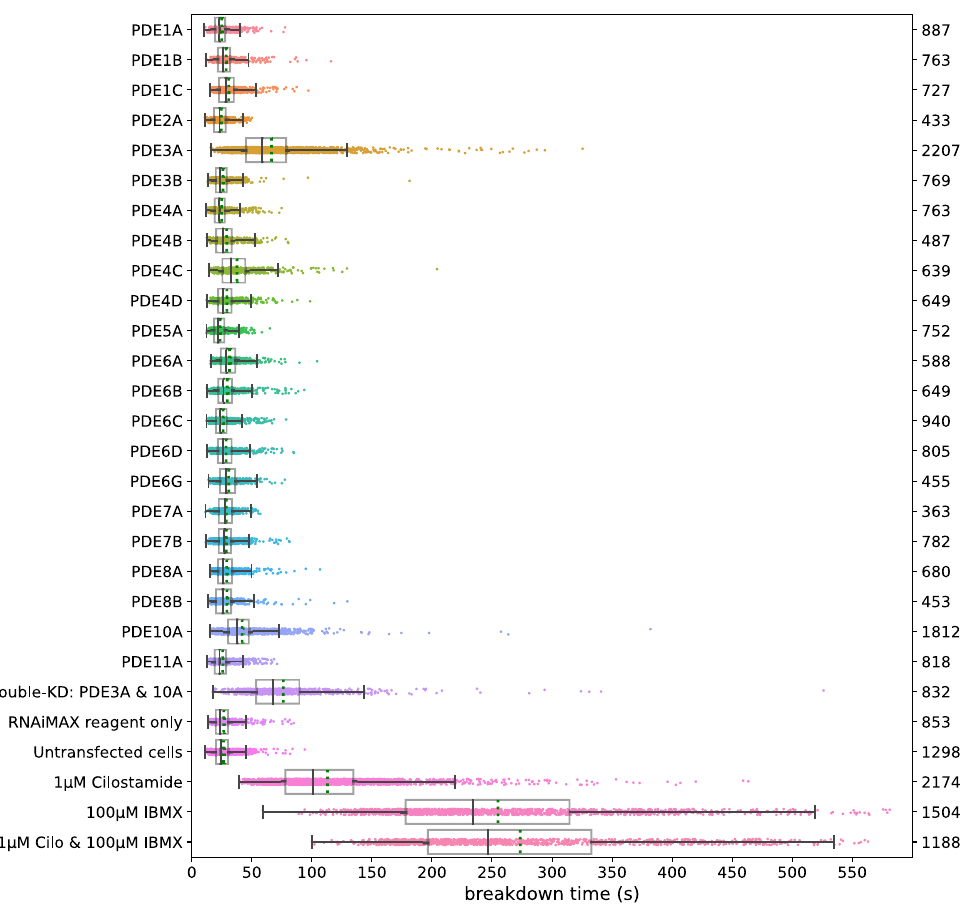
Figure 7. Breakdown of cAMP for different knockdowns of PDEs upon brief stimulation of the β-adrenergic pathway. For each condition, the experiment was performed in two independent wells. Further details are as in Fig.